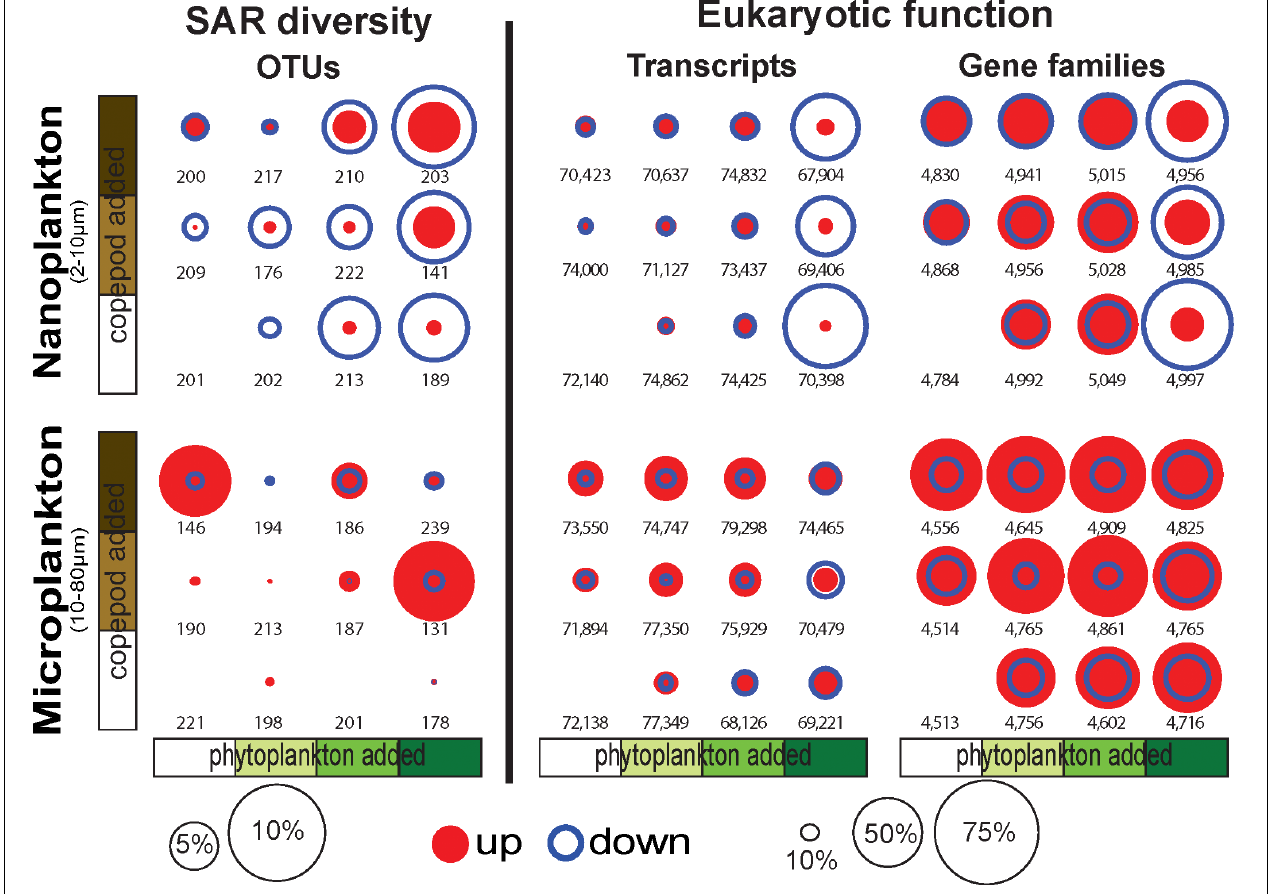
FIGURE 2 | Proportion of OTUs, transcripts, and conserved gene families (GFs) significantly increasing (up) or decreasing (down) in response to the incubation conditions show a large proportion of transcripts and GFs downregulated (up to 70% of the transcripts and GFs) in the nanoplankton with the phytoplankton bloom treatments. OTU, transcripts and GFs were identified with DESeq2 (Love et al., 2014). The numbers represent the total number of OTUs, transcripts, and GFs in the